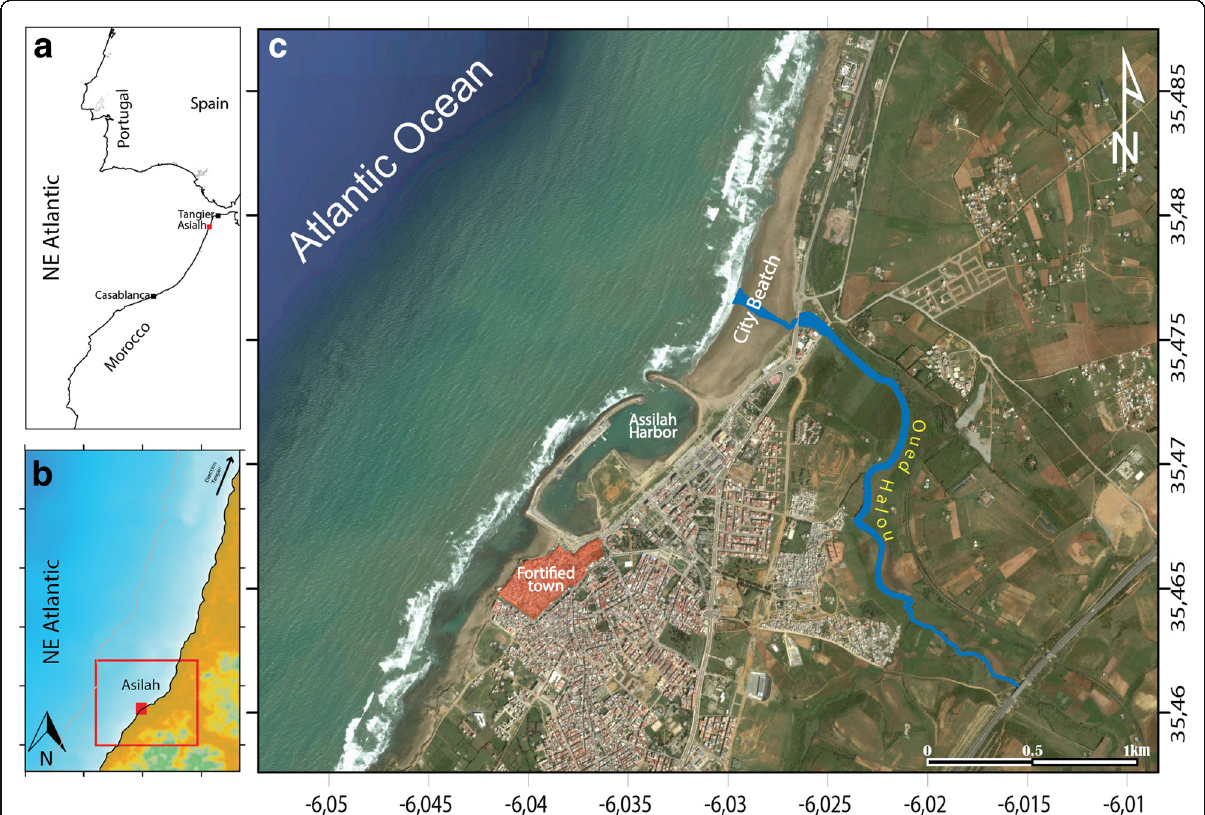
Fig. 1 Study area: ( a ) regional overview of the North East Atlantic area and the location of Asilah site in the Strait of Gibraltar, ( b ) Local overview of the location of Asilah site, ( c ) study area including the harbor, the city beach and principal locations in